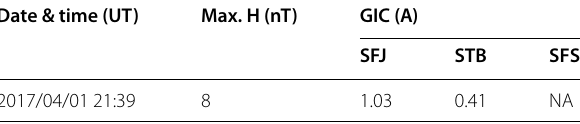
Table 6 SFE with the largest value of H-component geomagnetic field reported from KAK and maximum